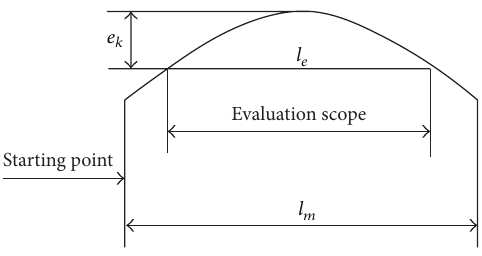
Figure 1: Modification curve of marine gear.